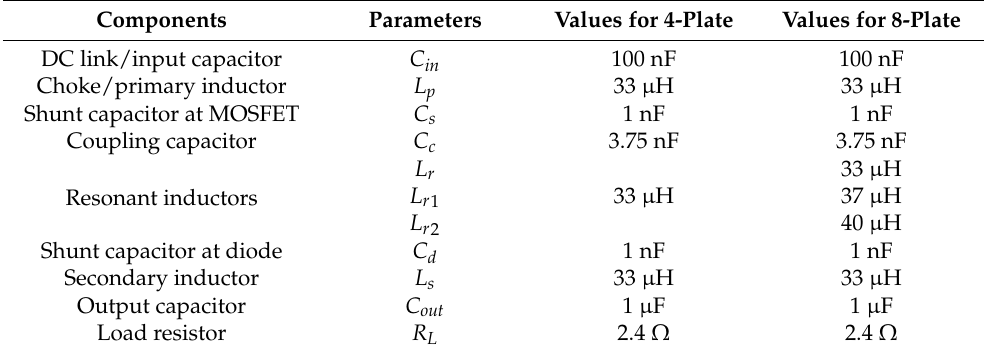
Figure 7. Experimental set of 8-plate capacitive coupling. Table 2. Parameters of class-E 2 power converter with 4-plate and 8-plate multi-resonant coupling.